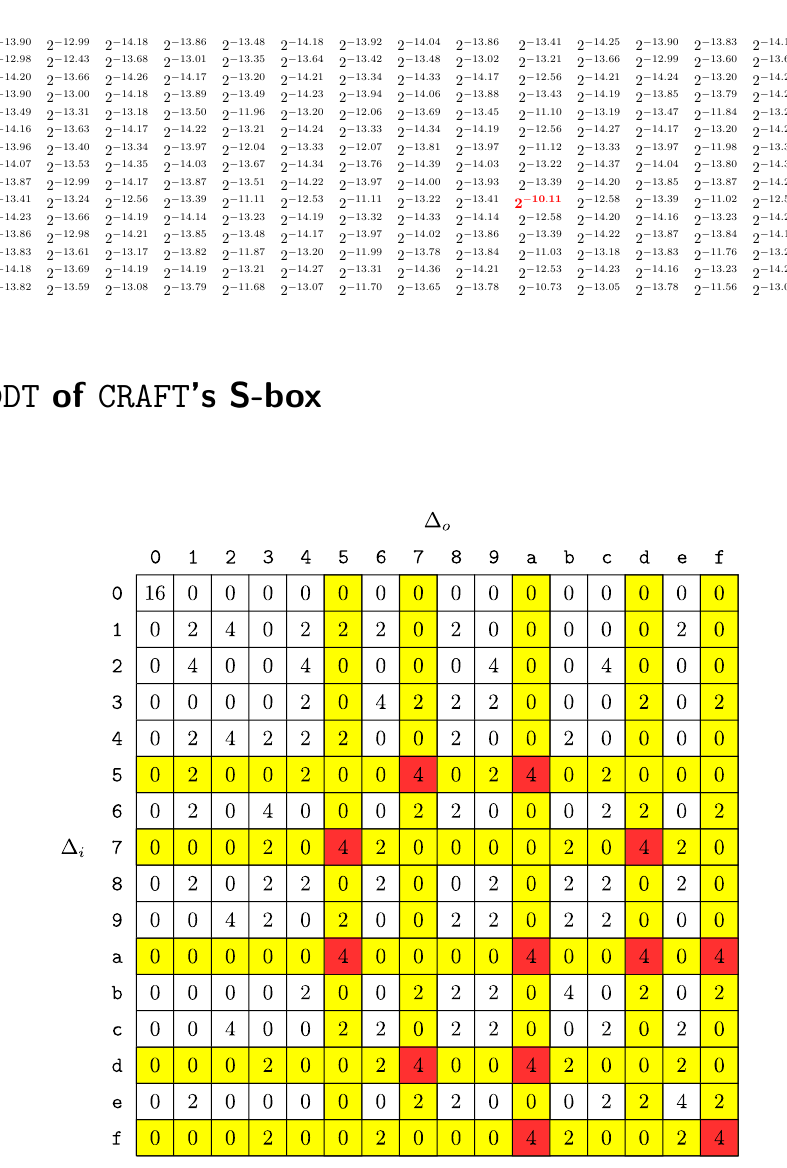
Figure 19: DDT of CRAFT ’s